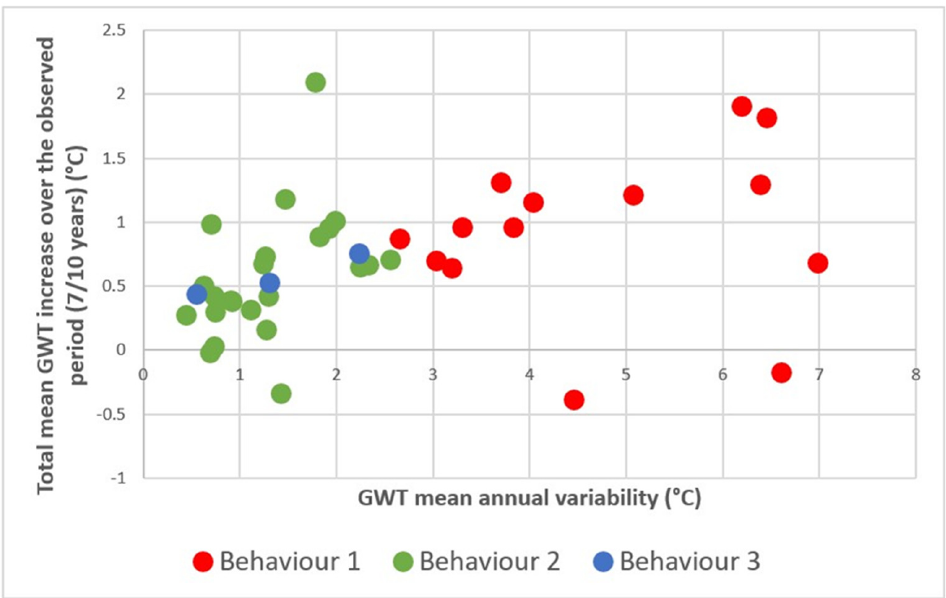
Figure 6. Correlation between mean annual variability of GWT and total GWT mean increase in the period observed.